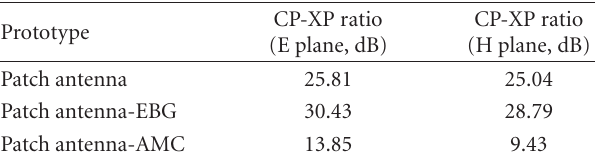
Table 2: CP-XP ratio